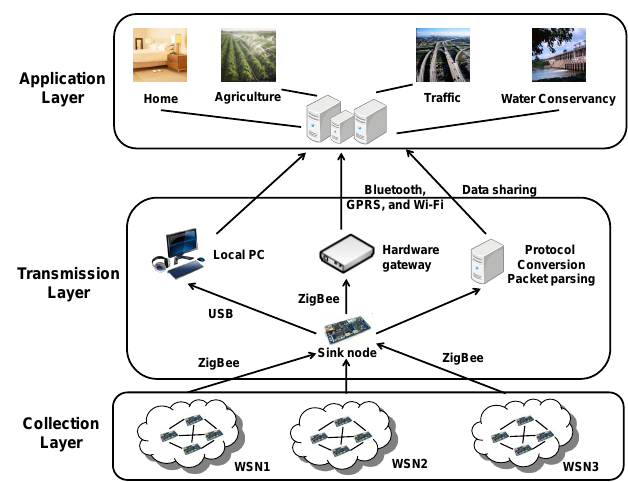
Figure 1. The different gateway architectures in WSN: the WSN1 is the normal WSN architecture without gateways; the WSN2 uses the gateway-based solutions; the WSN3 is the one using the middleware